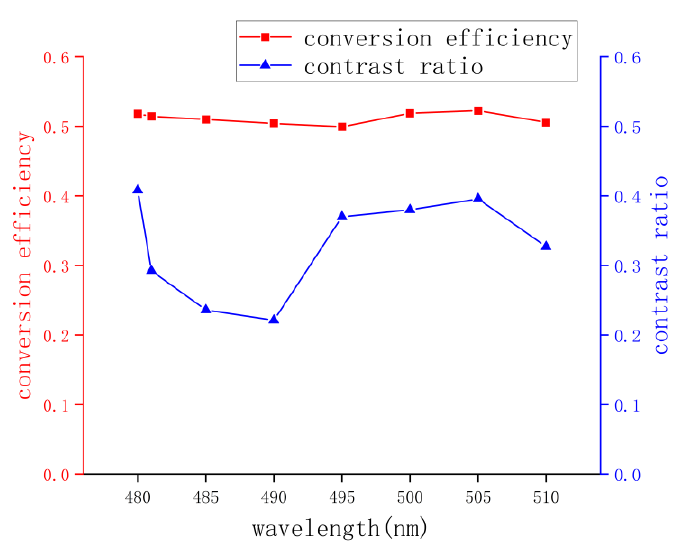
Figure 10. The conversion efficiency (red, y -axis on the left) and the contrast ratio (blue, y -axis on the right) of DG wavelengths from 480 nm to 510 nm.